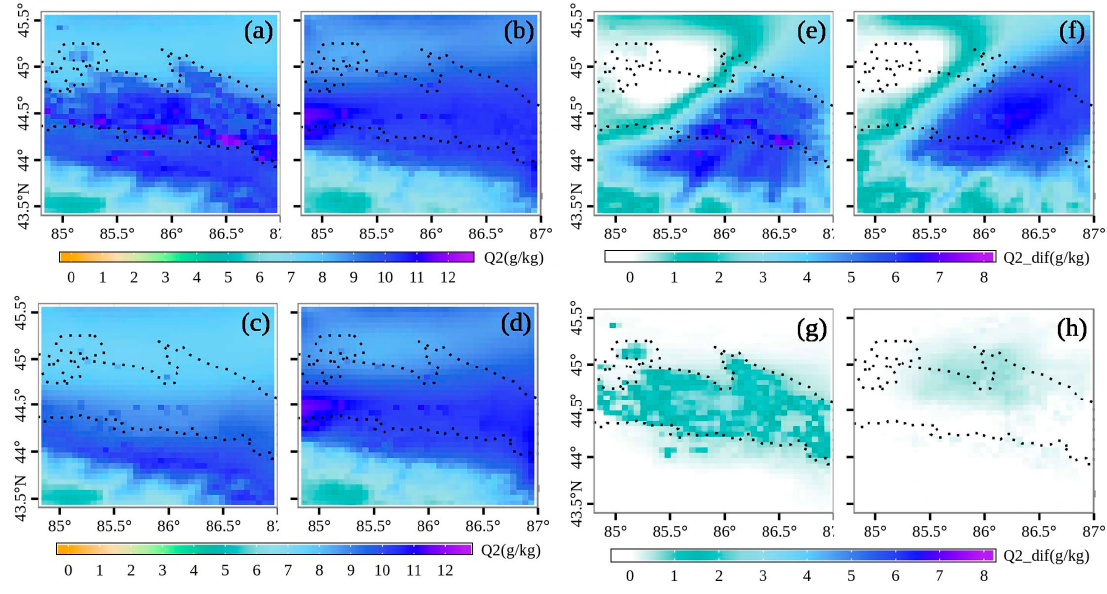
Figure 8. The same as Figure 6 but for surface specific humidity Q2 (g kg − 1 ).